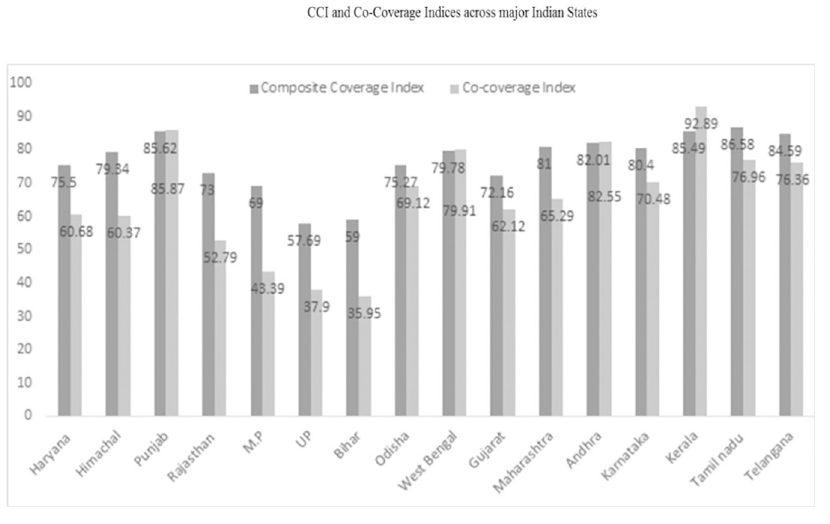
Table 1. Descriptive statistics of sampled pregnant women across major states of India: Quintile-wise disaggregation. States belonged to non-poor categories. Nearly 95 percent of the sampled population of Kerala and Punjab belonged to middle income quintile or richer quintile population. Fig 1 demonstrates the distribution of CCI and Co-Cov indices across major Indian states. The coverage of CCI is higher compared to Co-Cov indicator for all the states except Kerala, Punjab and Andhra Pradesh. The coverage of Co-Cov indicates disparate inequality across the states of India. According to this indicator, Kerala topped in terms of its performance. While Punjab, Uttar Pradesh (37.9 percent) and Bihar (35.95 percent) remained the back runners. The coverage of CCI is highest in Tamil Nadu (86.58 percent) and Punjab (85.62 percent),